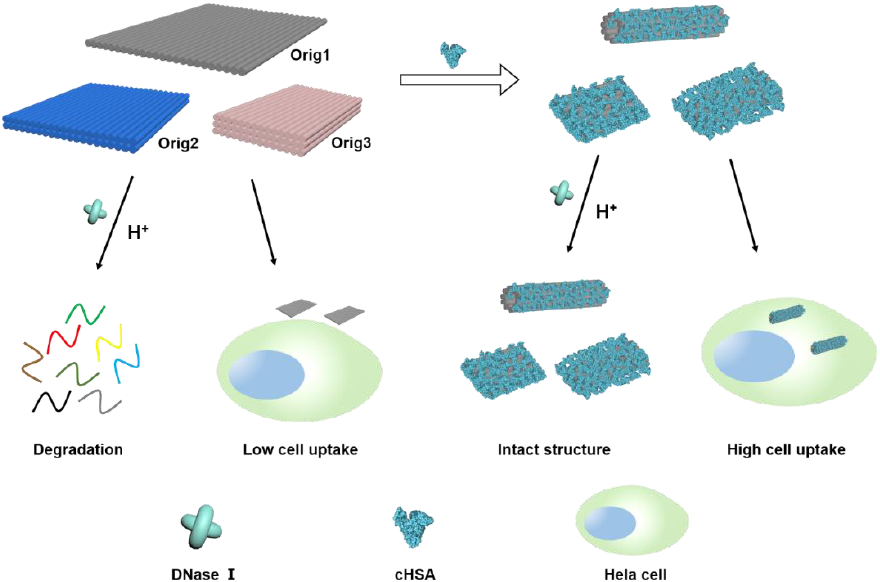
Figure 1. Schematic of cHSA coating strategy for enhancing the stability and transfection efficiency of DNA origami. DNA origami was coated by cHSA via electrostatic interaction between the negatively charged DNA origami and positively charged cHSA. Plain DNA origami was degraded by DNase I and dissociated at acidic pH, whereas coated origami was found to be resistant to DNase I digestion and stable under the acidic condition. The coated DNA origami nanostructures could also be transfected to cells more efficiently.